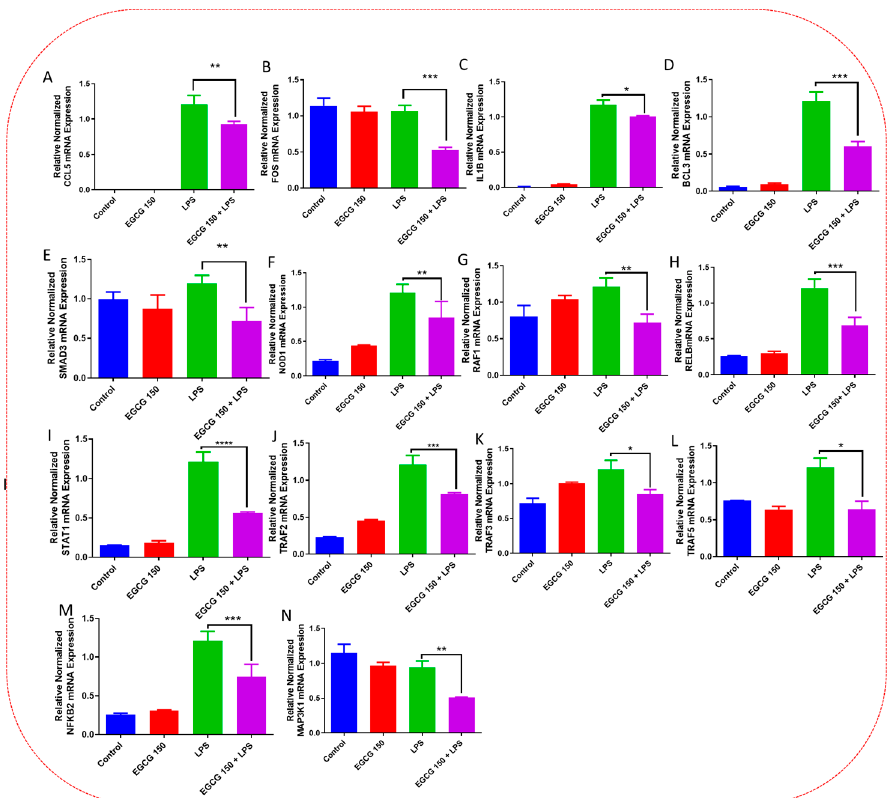
Figure 8. EGCG downregulated inflammation-mediating NF- κ B genes. PCR array evaluation established that EGCG 150 µM coupled with LPS (1 µg/mL) curtailed mRNA expression of the genes CCL5 ( A ), FOS ( B ), IL1B ( C ), BCL3 ( D ), SMAD3 ( E ), NOD1 ( F ), RAF1 ( G ), RELB ( H ), STAT1 ( I ), TRAF2 ( J ), TRAF3 ( K ), TRAF5 ( L ), NFKB2 ( M ), and MAP3K1 ( N ) compared to LPS. Values represent the mean ± SD, * p ≤ 0.05, ** p ≤ 0.01, *** p ≤ 0.001 and **** p ≤ 0.0001 vs. LPS.